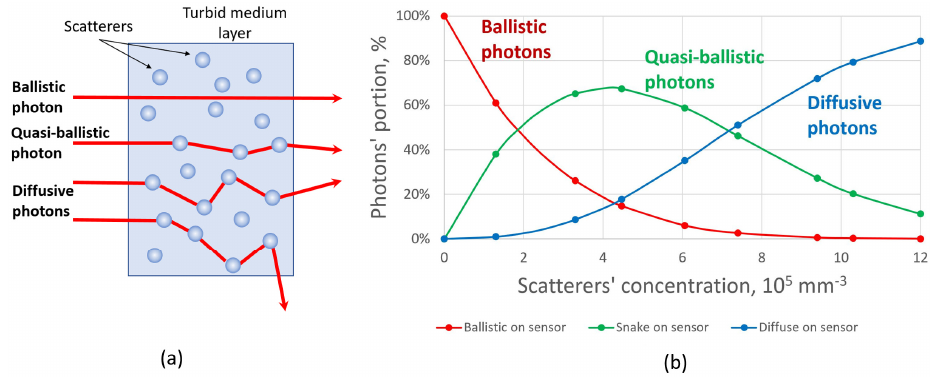
Figure 2. ( a ) Schematic trajectories of photons propagating through a scattering medium: ballistic, quasi-ballistic, and diffusive photons. ( b ) Number of photons reaching the sensor for the scatterers’ concentration range from 10 5 to 10 6 mm − 3 (numerical simulation